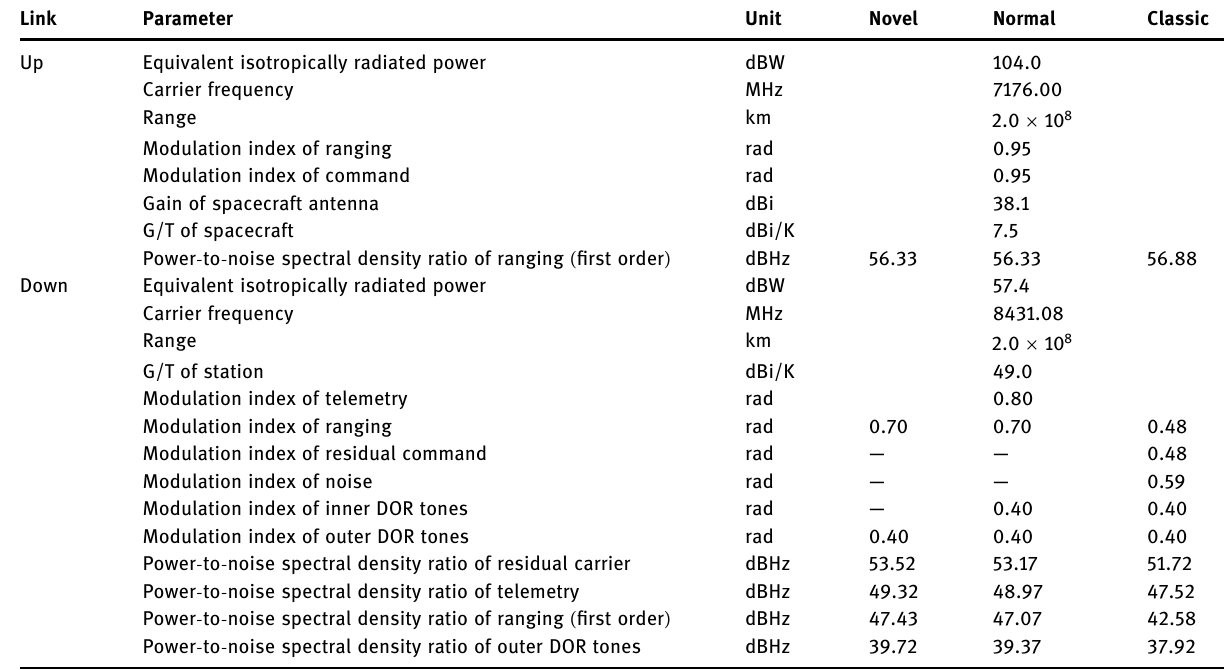
Table 1: Link budget for the novel, normal, and classic design cases Link